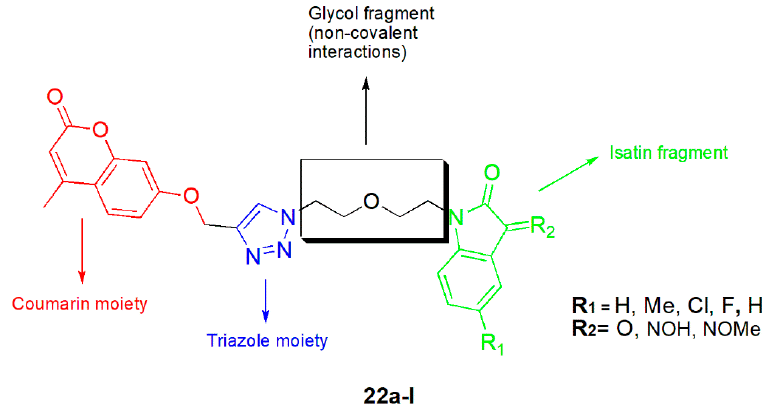
Figure 11. General structure of diethylene glycol tethered isatin-1,2,3-triazole-coumarin derivatives 22a-l.